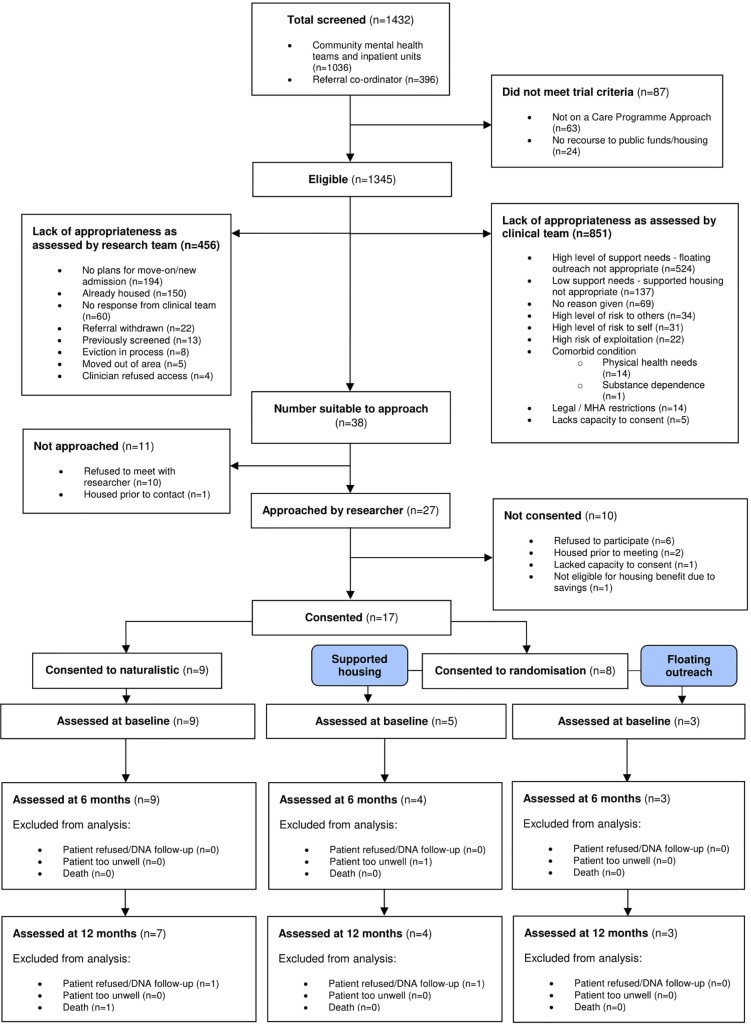
CONSORT diagram.